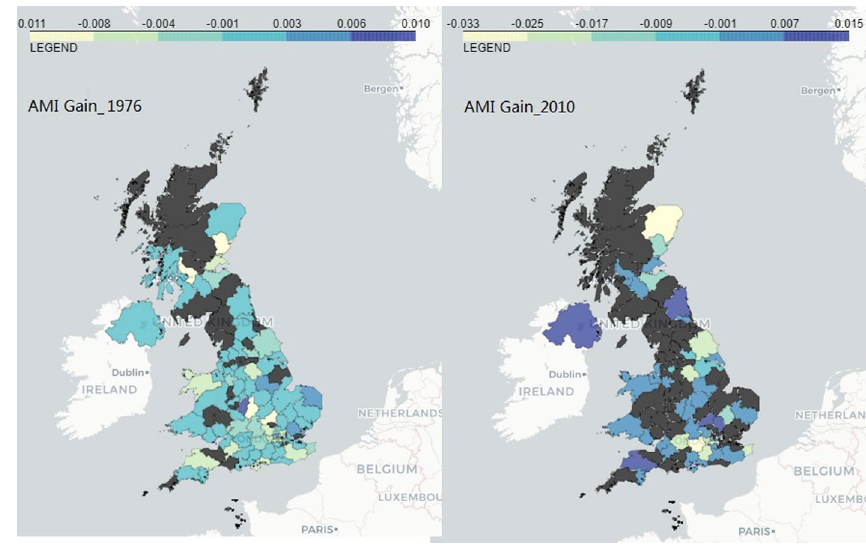
Fig. 4 UK postcode areas with AMI gains in the pharmaceuticals and biotechnology